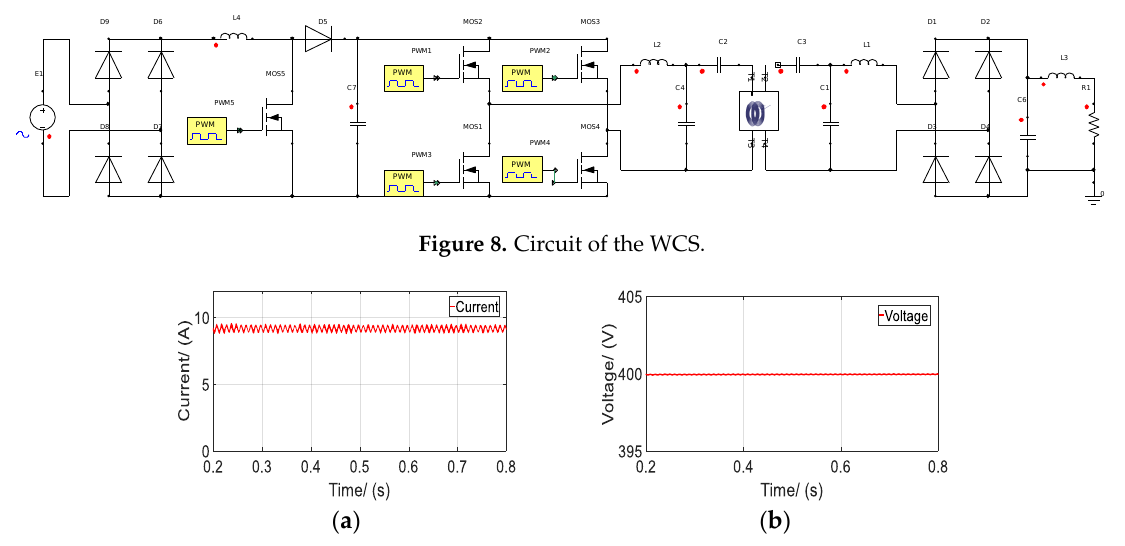
Figure 9. Charging parameters: ( a ) Current; ( b ) Voltage.